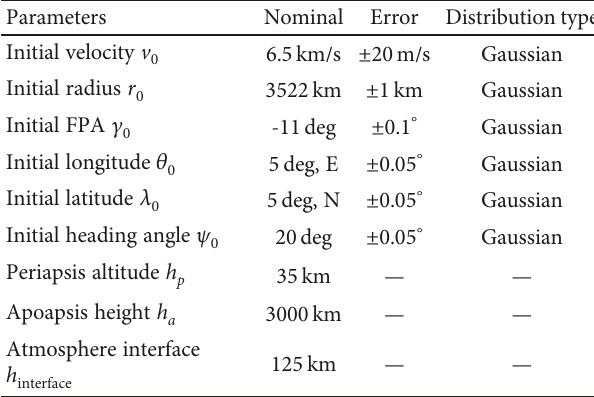
Table 2: Initial state and desired orbit for Monte Carlo simulation [6].